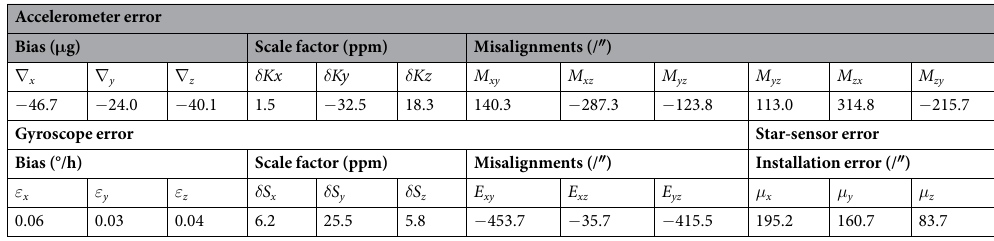
Table 2. Estimated results of IMU and the star